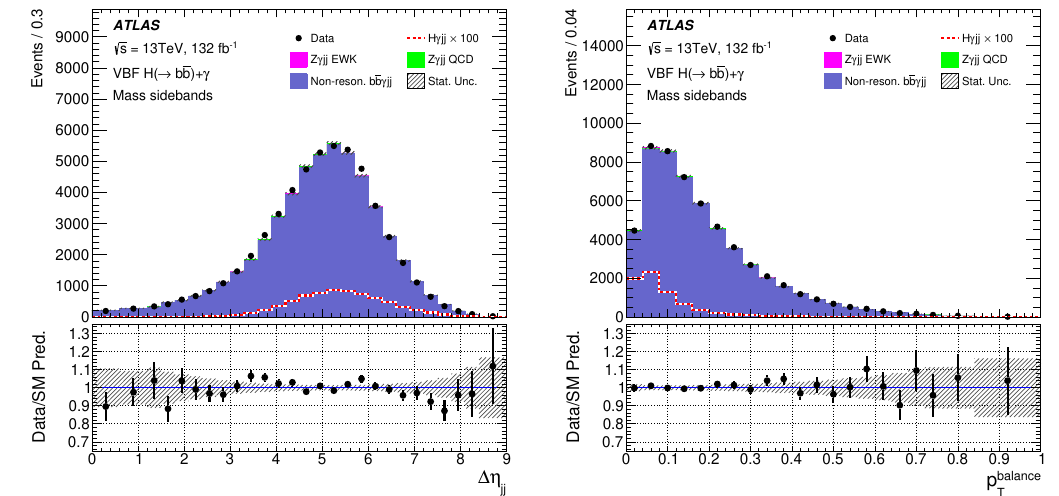
Figure 2 . Comparisons of data and simulated event distributions of the BDT input variables (cid:1) (cid:17) jj (left) and p balance (right) in the two m bb sidebands after kinematic reweighting of the non-resonant T b (cid:22) b(cid:13)jj background. The data are shown as black points, and the background contributions are stacked in coloured histograms. The Higgs boson signal contribution is scaled up and represented by the dashed red line. The bottom panel in each plot shows the ratio of the data to the SM prediction, where the uncertainty band corresponds to the statistical uncertainty